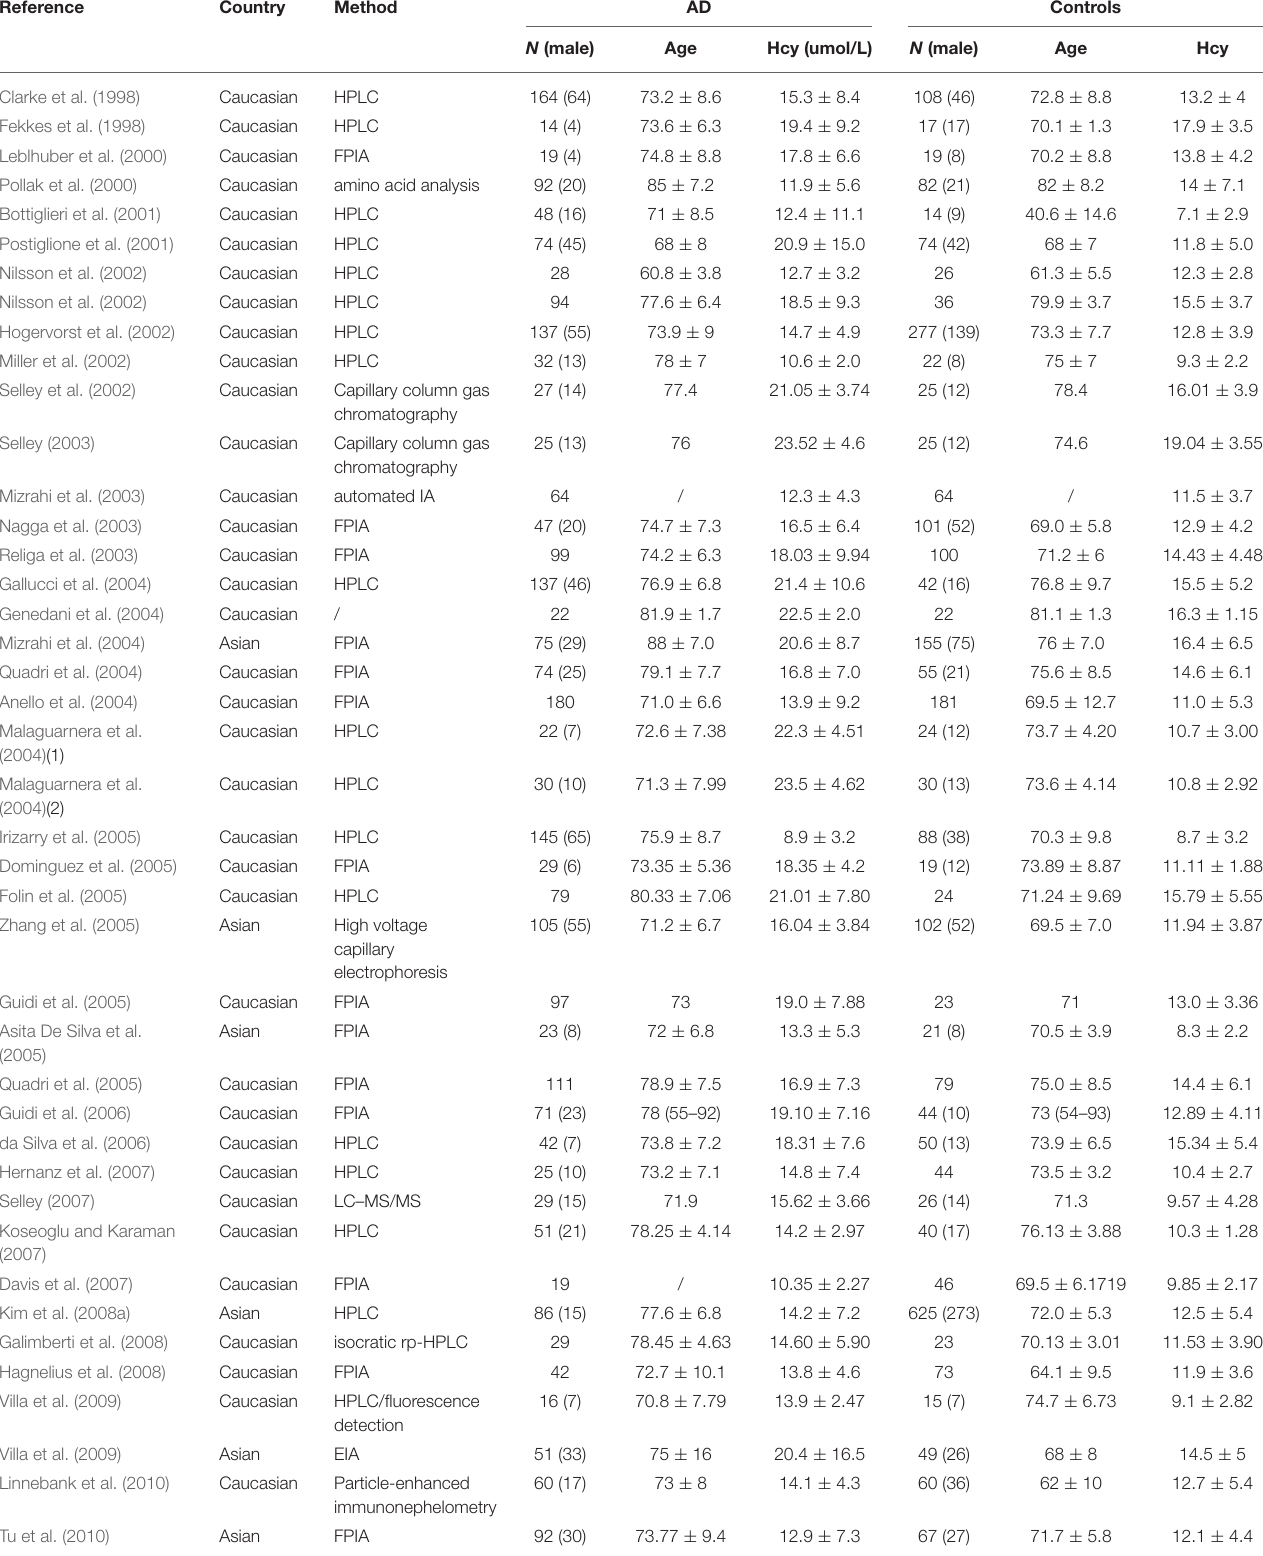
TABLE 1 | The baseline characteristics of included studies